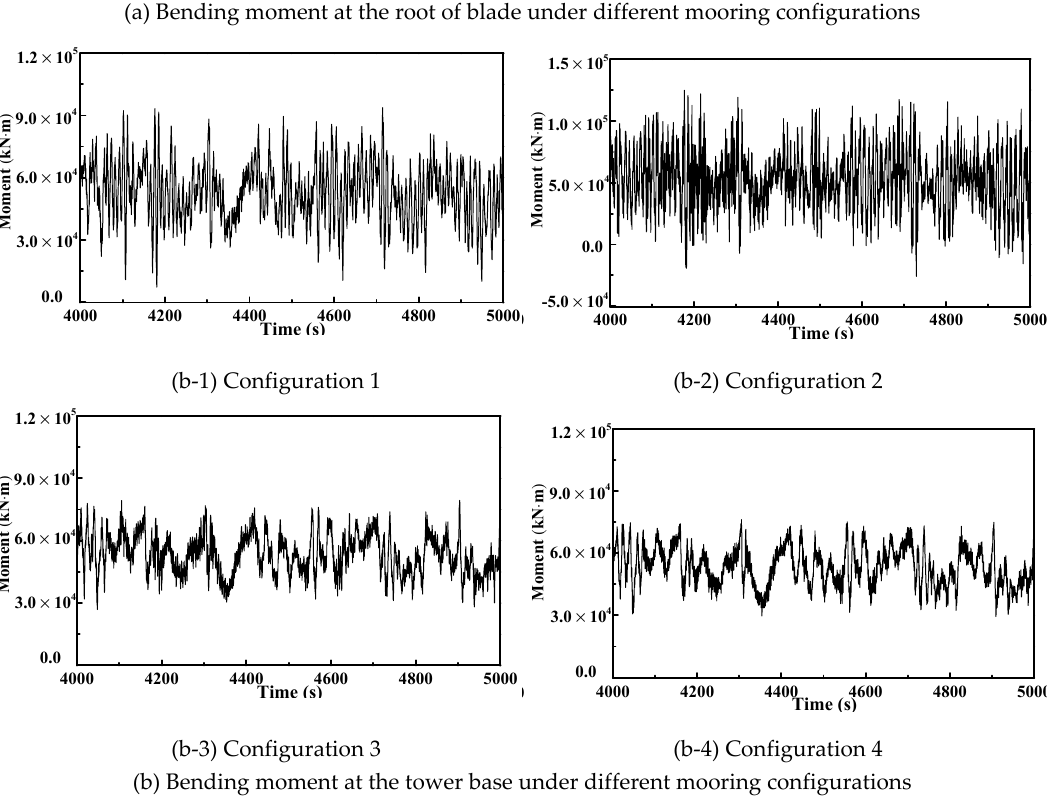
Figure 5. Time series of the bending moment at the root of blade and tower base under different mooring configurations.